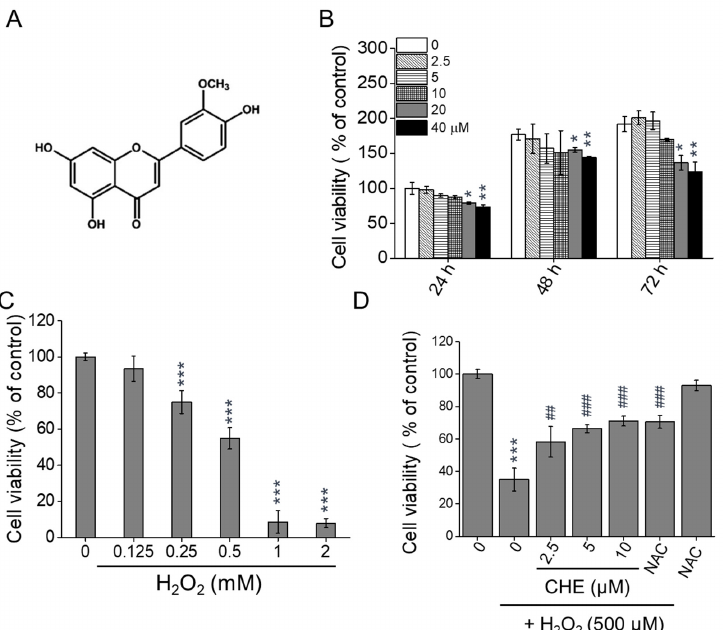
Figure 1. Protective effects of chrysoeriol (CHE) against H 2 O 2 -induced cytotoxicity in ARPE-19 cells. ( A ) Schematic drawing of the structures of the CHE complexes. ( B ) Cells were treated with CHE (2.5–40 µ M) or 0.1% DMSO (vehicle control) for 24–72 h, and the cell viability was measured. ( C ) Cells were treated with H 2 O 2 (0.125–2 mM) for 24 h, and the cell viability was measured. ( D ) Cells were pre-treated with CHE at the indicated concentrations or 0.1% DMSO (vehicle control) for 2 h and then incubated with or without 500 µ M H 2 O 2 for 24 h. N -acetyl-cysteine (NAC, 4 mM) was used as an antioxidant control. Cell viability was measured via the CCK-8 assay (B, C, and D). * p < 0.05, ** p < 0.01, *** p < 0.001, versus the control group; ## p < 0.01, ### p < 0.001, versus the H 2 O 2 -treated